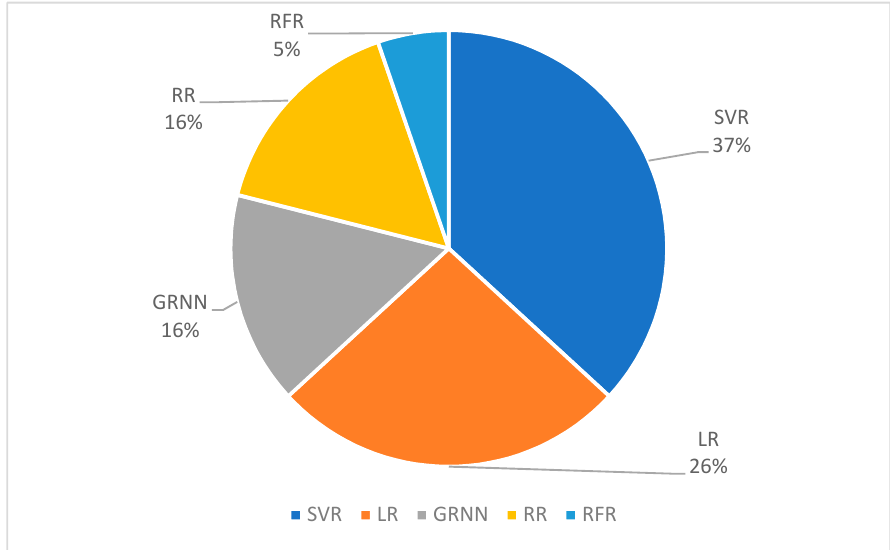
Figure 11. Percentages of the different regression algorithms reported in FMG literature ( n = 19). SVR is the counterpart of SVM in the regression domain and both SVR and SVM are based on the same core principle, which is to identify the supported vector from the input data and form the